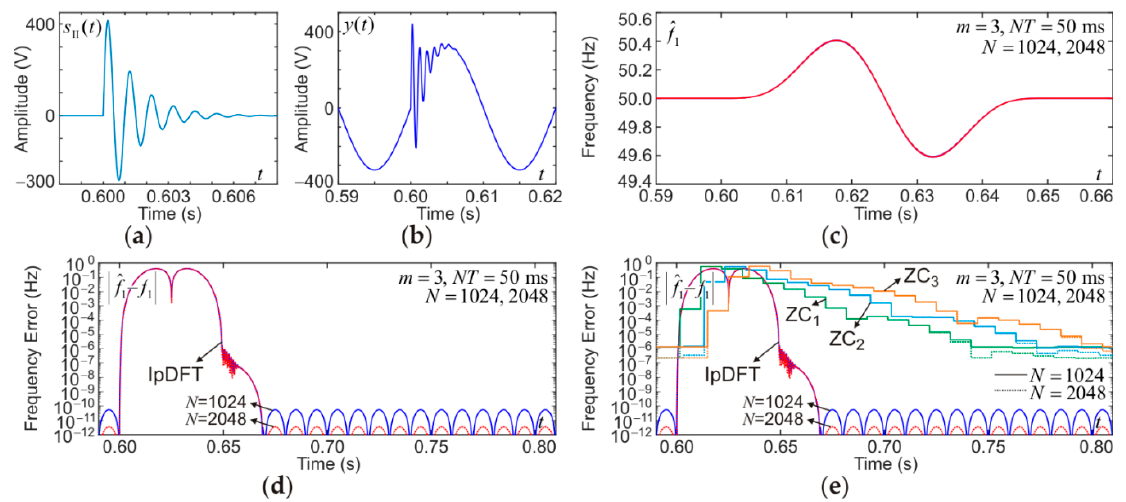
Figure 17. Effect of low-frequency pulse interference on estimation results: ( a ) disturbing pulse; ( b ) 50 Hz power network signal disturbed by pulse; ( c , d ) estimation result of IpDFT method for m = 3 at 50 ms measurement time and for N = 1024 and 2048; ( e ) Comparison of accuracy of IpDFT method for m = 3 and NT = 50 ms with ZC method for N = 1024 and 2048.